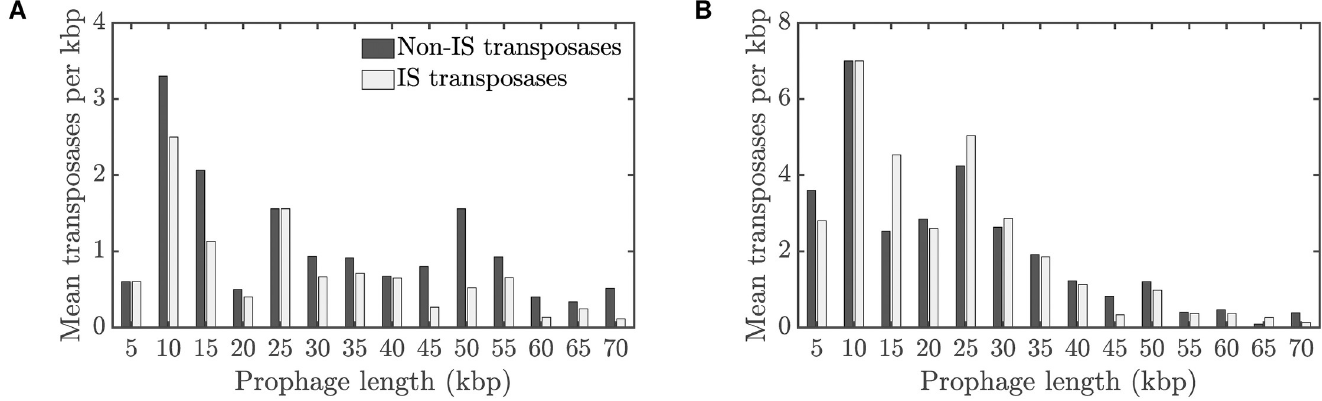
Fig 8. Average number of transposases per kbp of prophage sequence, for prophages of different lengths: (A) Average number of transposases per kbp of prophage sequence for Data Set 1. (B) Average number of transposases per kbp of prophage sequence for Data Set 2.